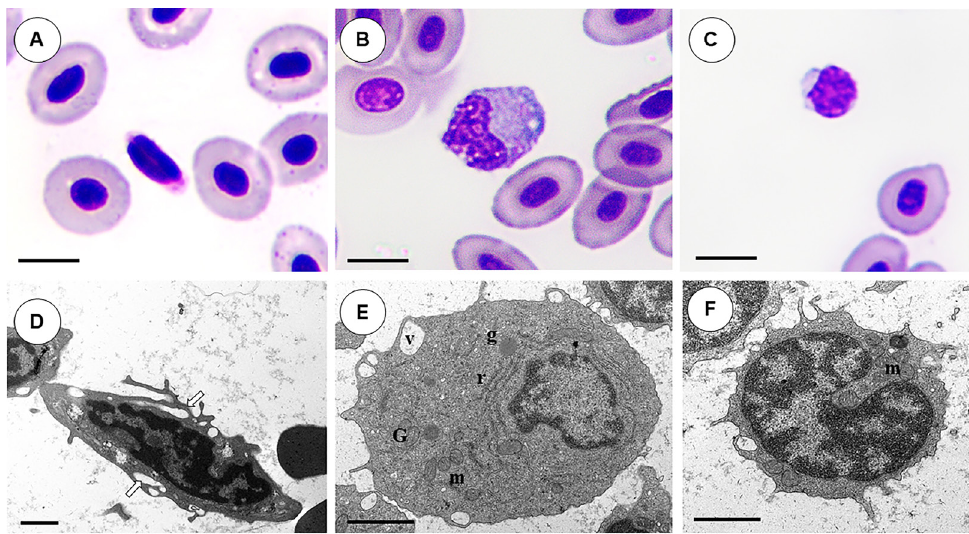
FIGURE 2 | Erythrocytes, thrombocytes and lymphocyte in Pygocentrus nattereri from Brazilian Pantanal in light ( A , B , C ) and transmission electronic microscopy ( D , E , F ). A and D . Thrombocytes of elongated shape and scarce cytoplasm rich in canalicular system (arrow). B and E , monocytes of irregular shape, chamfered nucleus, abundant cytoplasm mitochondria (m), vacuoles (v), glycogen granules (g), Golgi apparatus (G), and free ribosomes (r) are also observed. C and F . Small lymphocyte with numerous projections, a large nucleus, and scarce cytoplasm with few mitochondria and organelles. ABC. May Grunwald-Giemsa-Wright stain. Scale bars = A – C = 10 µm; D – F = 2